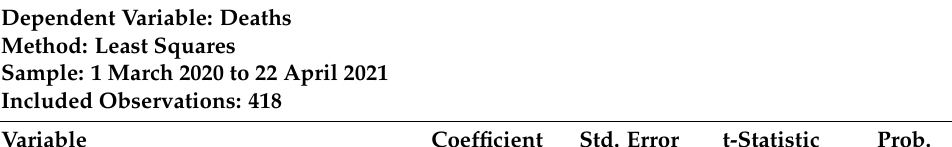
Table 4. Test results of the predictive capability of a linear model of deaths in Saudi Arabia.